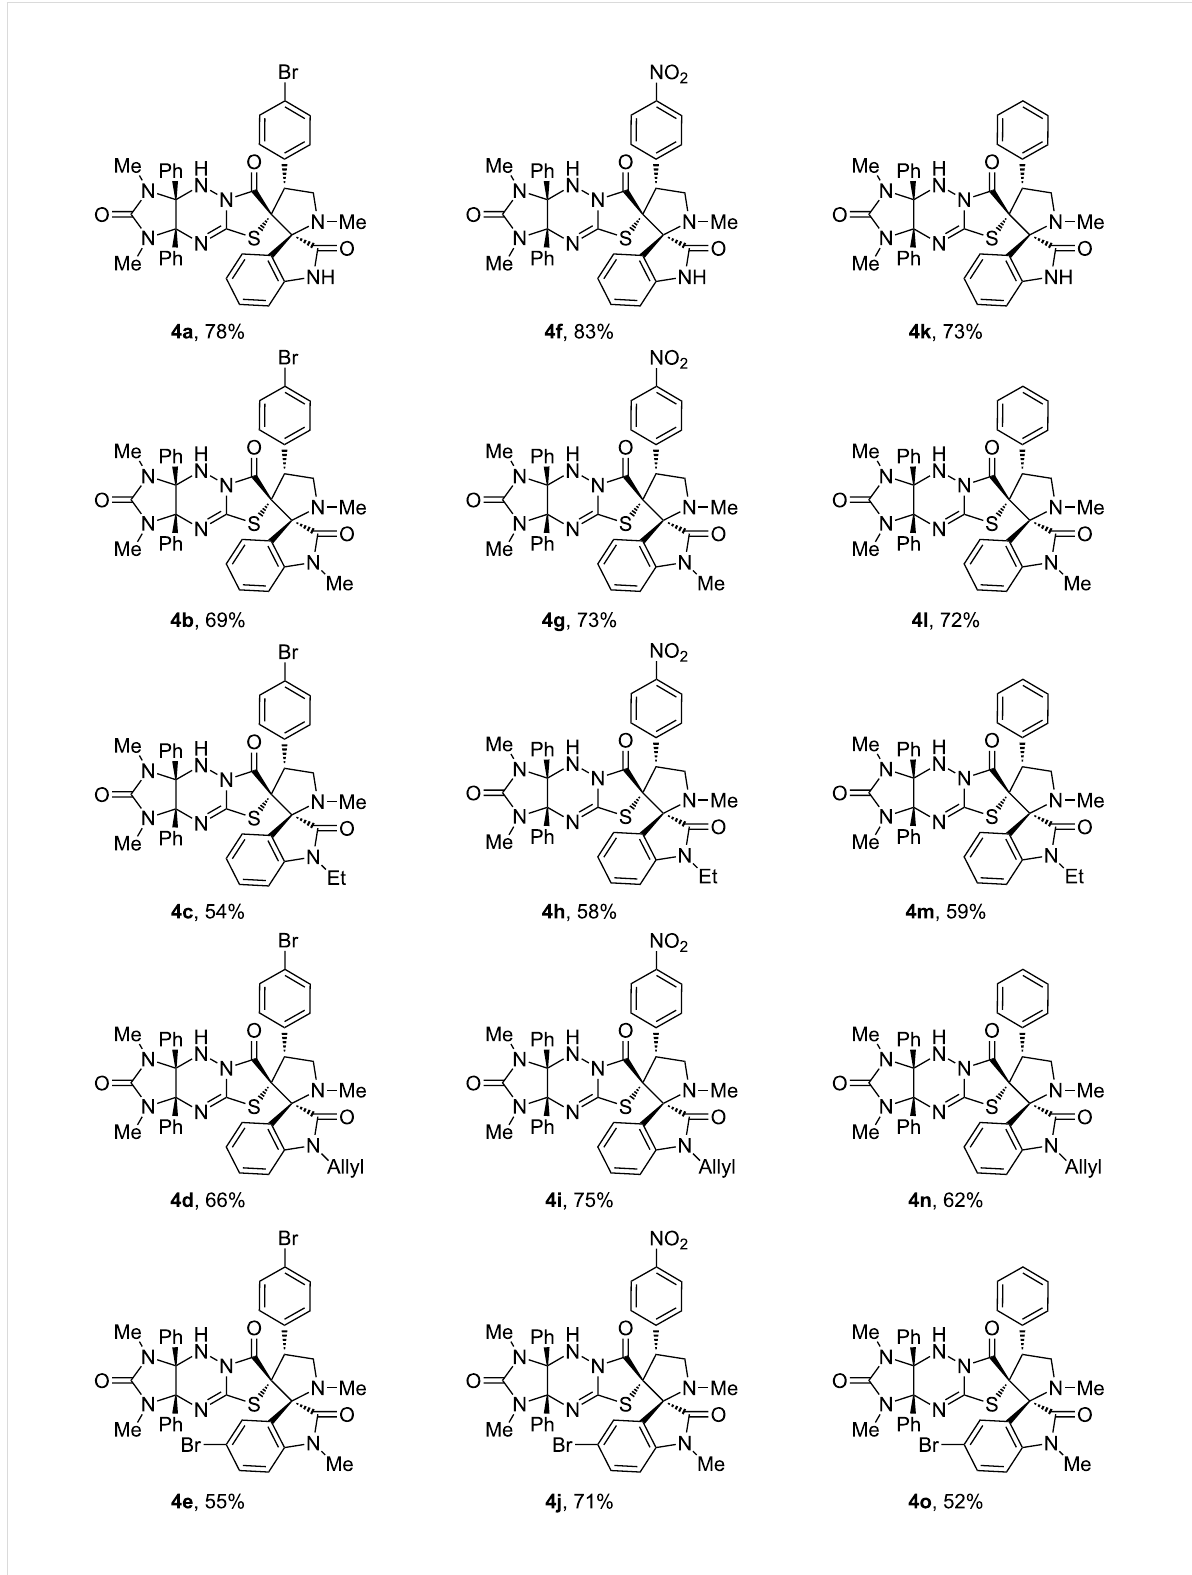
Figure 2: Synthesis of dispiro compounds 4a – o . Reaction conditions: heating the mixture of compounds 1 (0.5 mmol), isatins 3 (0.5 mmol), and sarcosine (0.5 mmol) in acetonitrile (40 mL) for 36